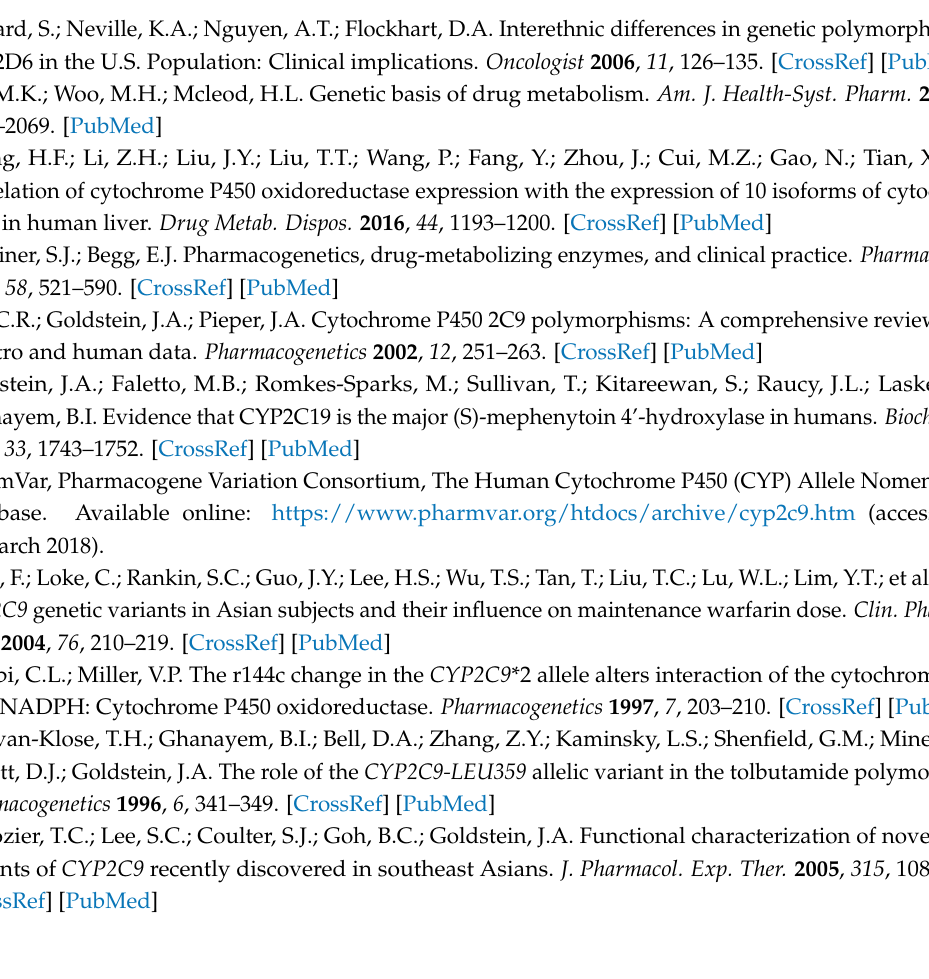
Table S1: Demographics of the subjects included in present study, Table S2: Primers used for CYP2C9, CYP2D6 and CYPOR SNPs amplification and sequencing, Table S3: Distribution of Cyp2C9, Cyp2D6 and CYPOR variants in Pakistani population and global populations from 1000 Genomes Project Database, Table S4: Genotype and Allele (%) frequency distributions of CYP2C9, CYP2D6and CYPOR SNPs in indigenous Pakistani